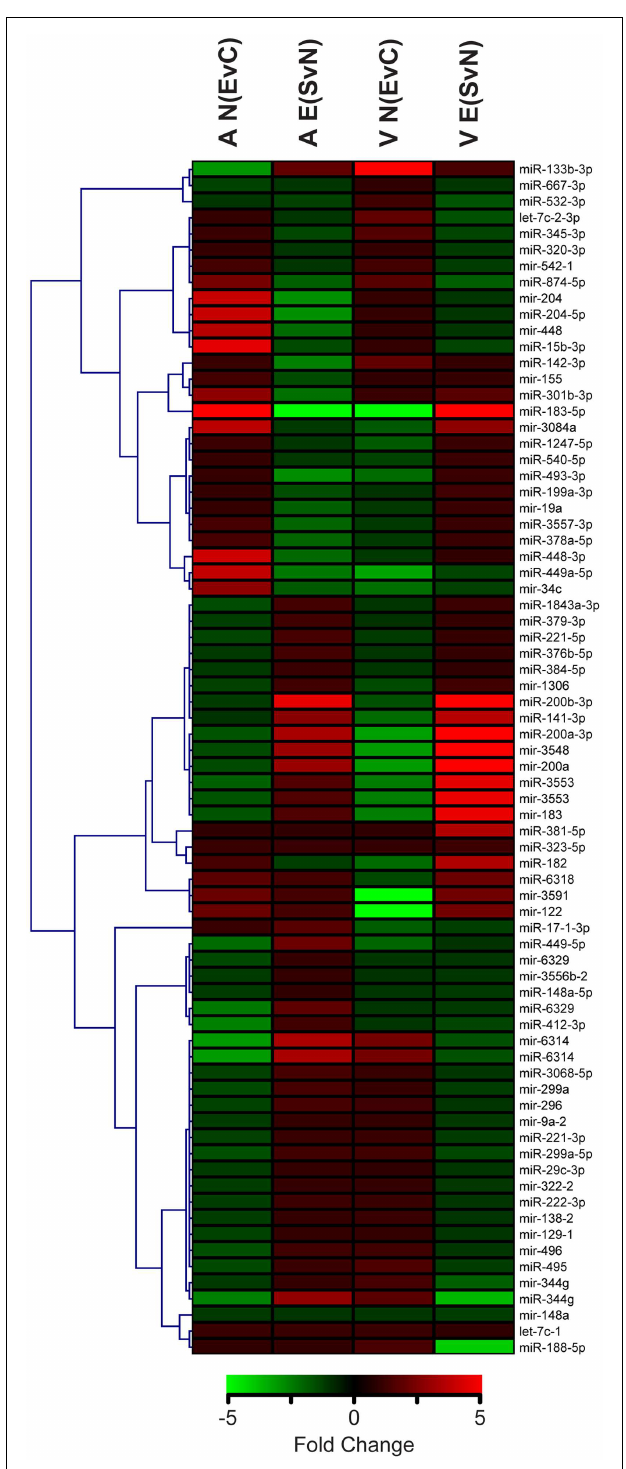
FIGURE 2 | Clustering of microRNAs with ethanol and/or social enrichment effects . Hierarchical clustering analysis of fold change values in miRNAs with significant ethanol effects in non-enriched rats [N(EvC)] and social enrichment effect in ethanol rats [E(SvN)] for both brain regions [A